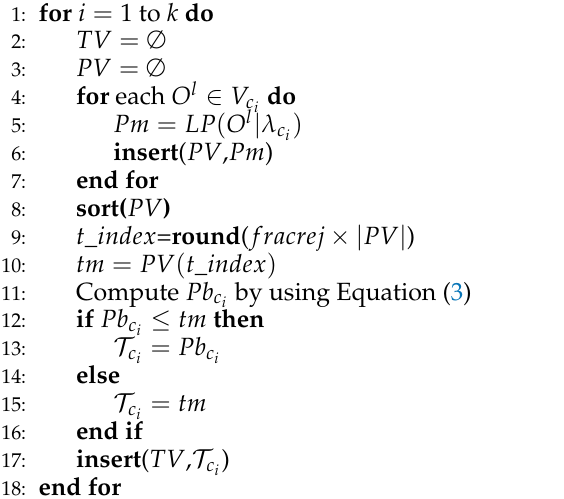
) on the induced action i